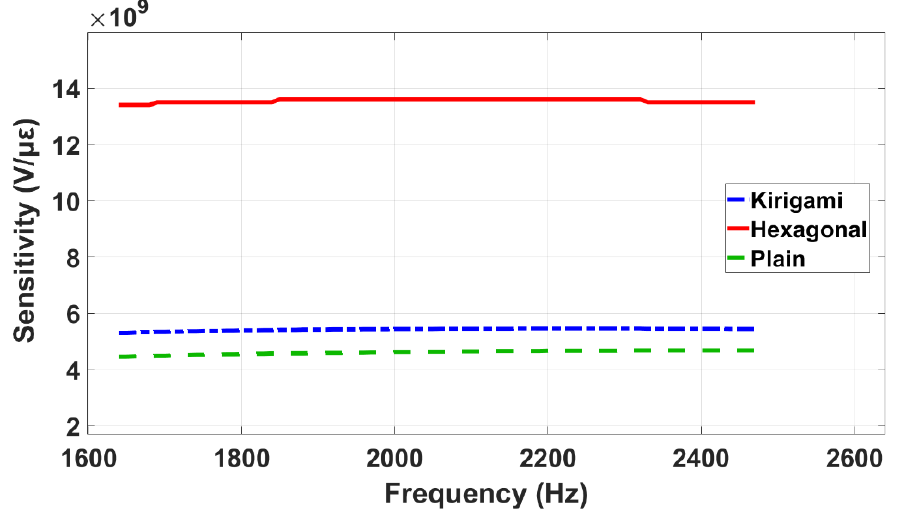
Figure 17. Sensitivity performance against frequency of the three sensor models.